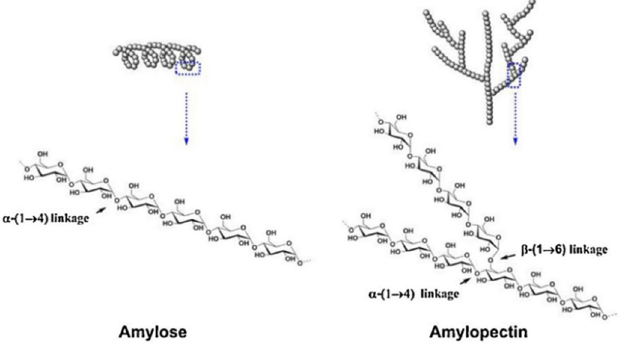
Figure 1. Illustration of amylose and amylopectin structures [8].